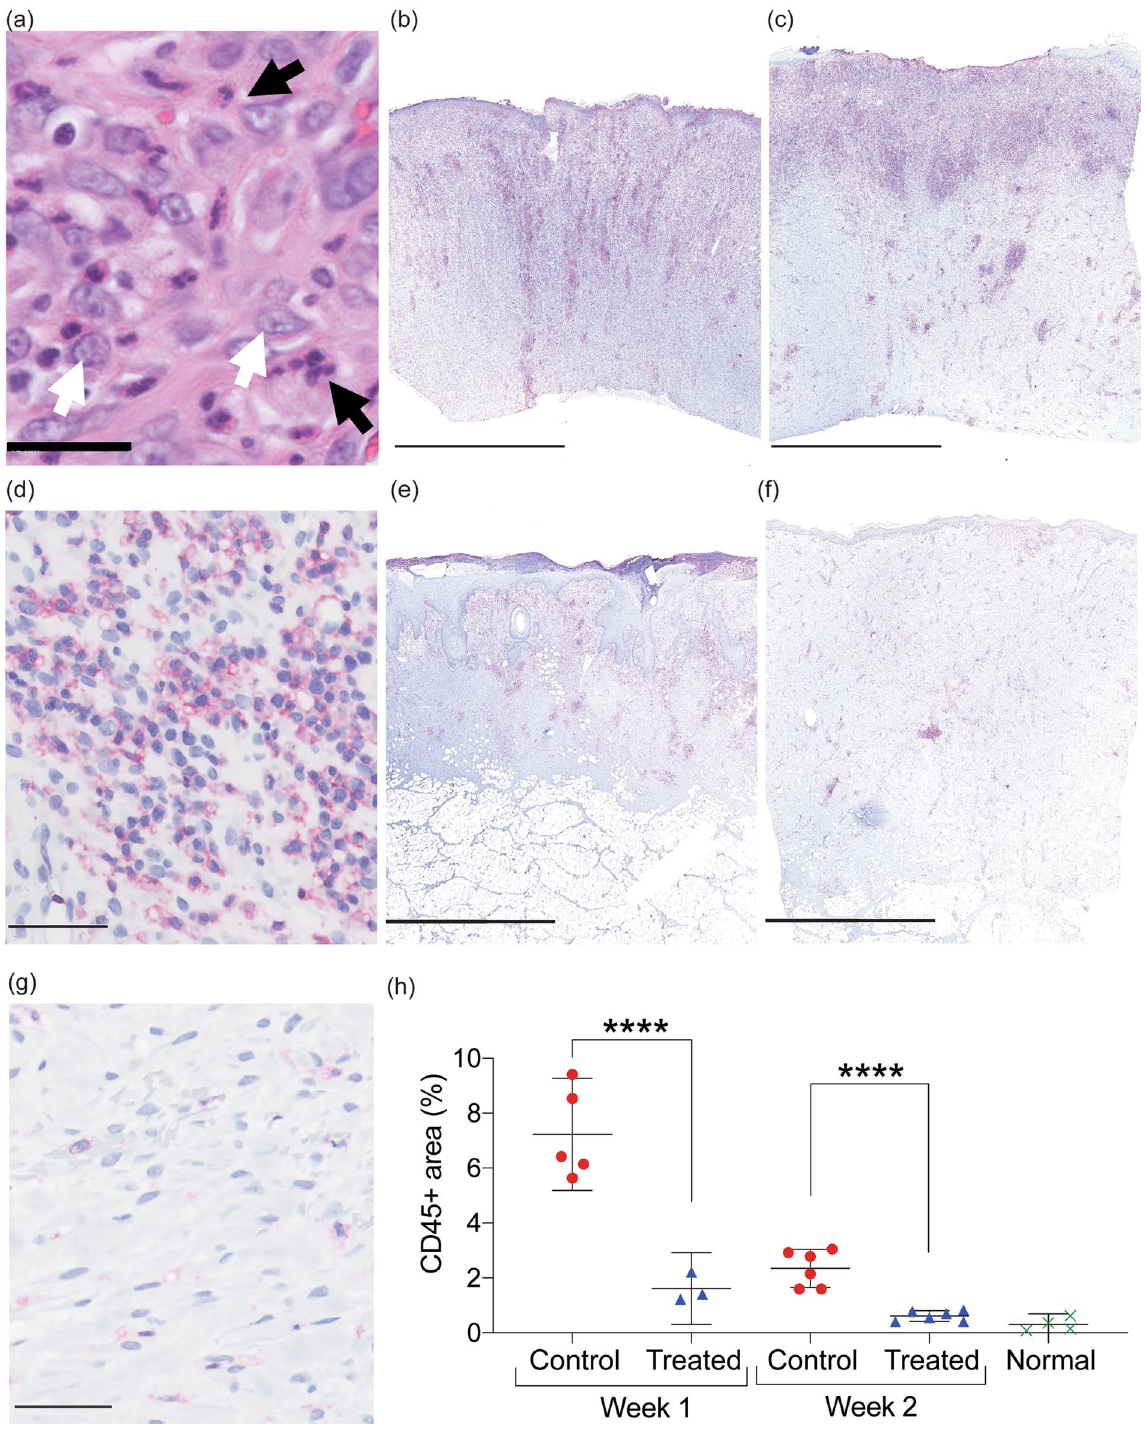
Figure 5. Attenuation of inflammatory response in wounds treated with MSTCs. ( a ) H&E staining showing inflammatory infiltrate in control wounds, with high densities of neutrophils and macrophages (identifiable by their characteristic polymorphic and euchromatic nuclei, respectively). Scale bar = 25 μm. ( b ) Whole- biopsy view of CD45 staining (red) in a control wound at 1 week. Scale bar = 2.5 mm. ( c ) CD45 staining of a control wound at 2 weeks. Scale bar = 2.5 mm. ( d ) High-power view of CD45 staining in a control wound at 2 weeks. Scale bar = 50 μm. ( e ) Whole-biopsy view of CD45 staining of an MSTC-treated wound 1 week. Scale bar = 2.5 mm. ( f ) CD45 staining of an MSTC-treated wound at 2 weeks. Scale bar = 2.5 mm. ( g ) High-power view of CD45 staining in an MSTC-treated wound at 2 weeks. Scale bar = 50 μm. ( h ) Quantitative evaluation of CD45+ areas in MSTC-treated vs. control wounds. Density of CD45+ leukocytes was significantly lower in MSTC-treated wounds compared to controls at both time points. ****p ≤